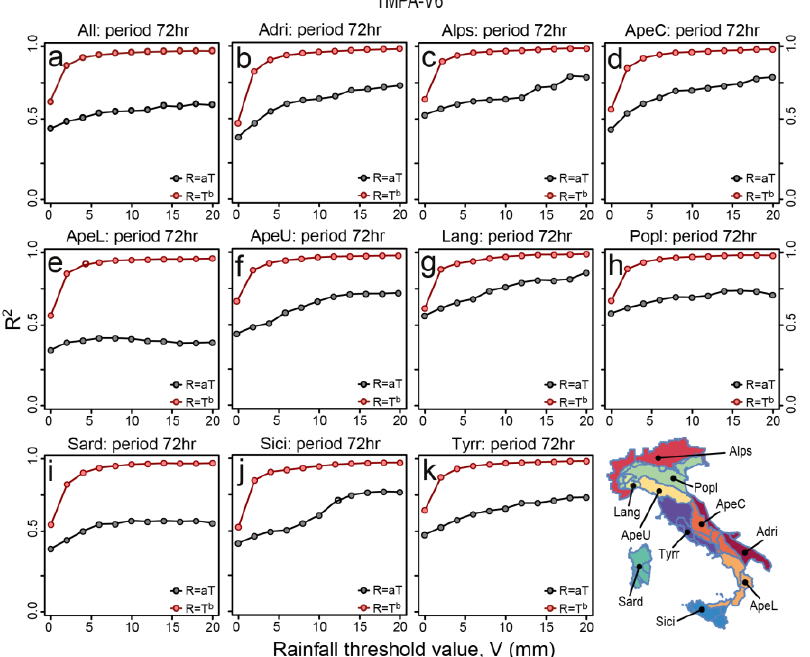
Figure 5. Linear (grey dots) and power-law (red dots) fitting (between TMPA-V6 rainfall estimates and VRF ground data) determination coefficients for 72-h cumulative rainfall filtered using a peak over threshold approach taking values above different thresholds: 0, 2, 4, 6, 8, 10, 12, 14, 16, 18 and 20 mm. The different plots show results for different morphological subdivisions: ( a ) entire Italian territory; ( b ) Adri; ( c ) Alps; ( d ) ApeC; ( e ) ApeL; ( f ) ApeU; ( g ) Lang; ( h ) Popl; ( i ) Sard; ( j ) Sici; ( k ) Tyrr.